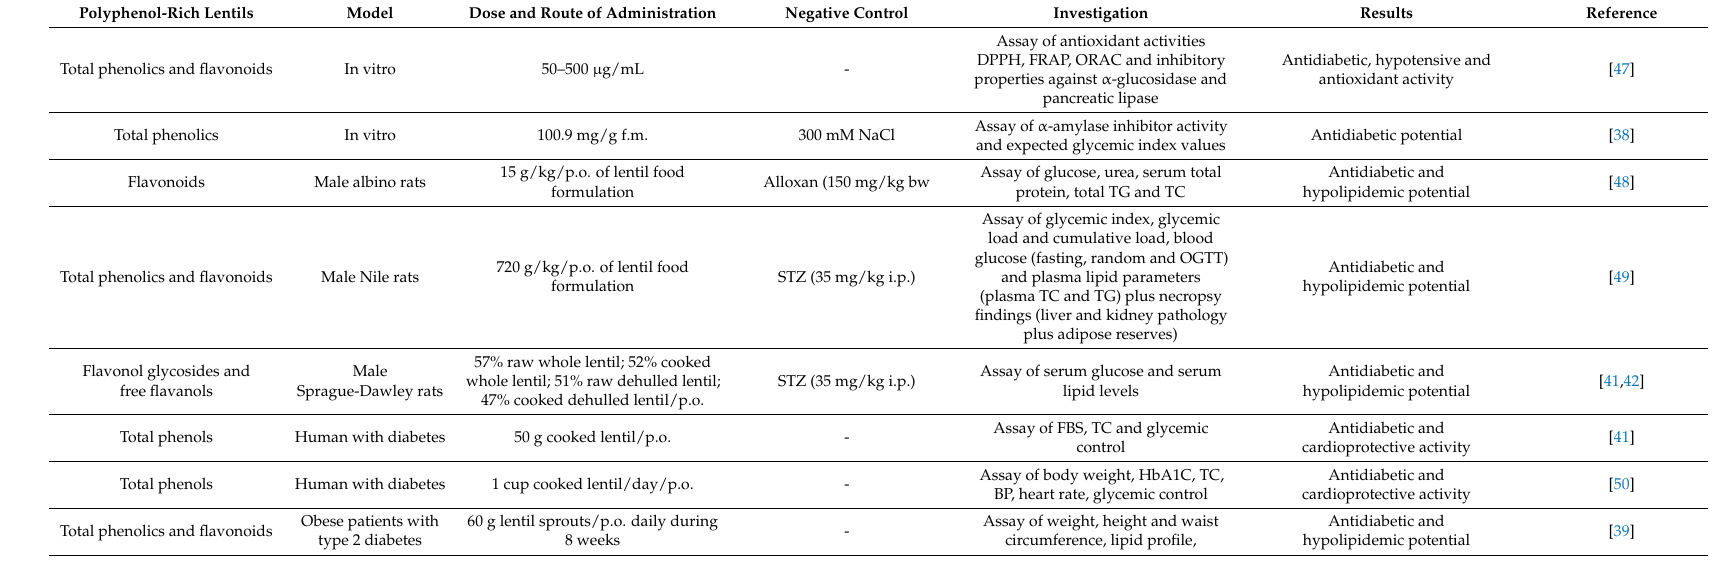
Table 4. Summary of in vitro, in vivo and clinical studies on the antidiabetic activities of polyphenol-rich